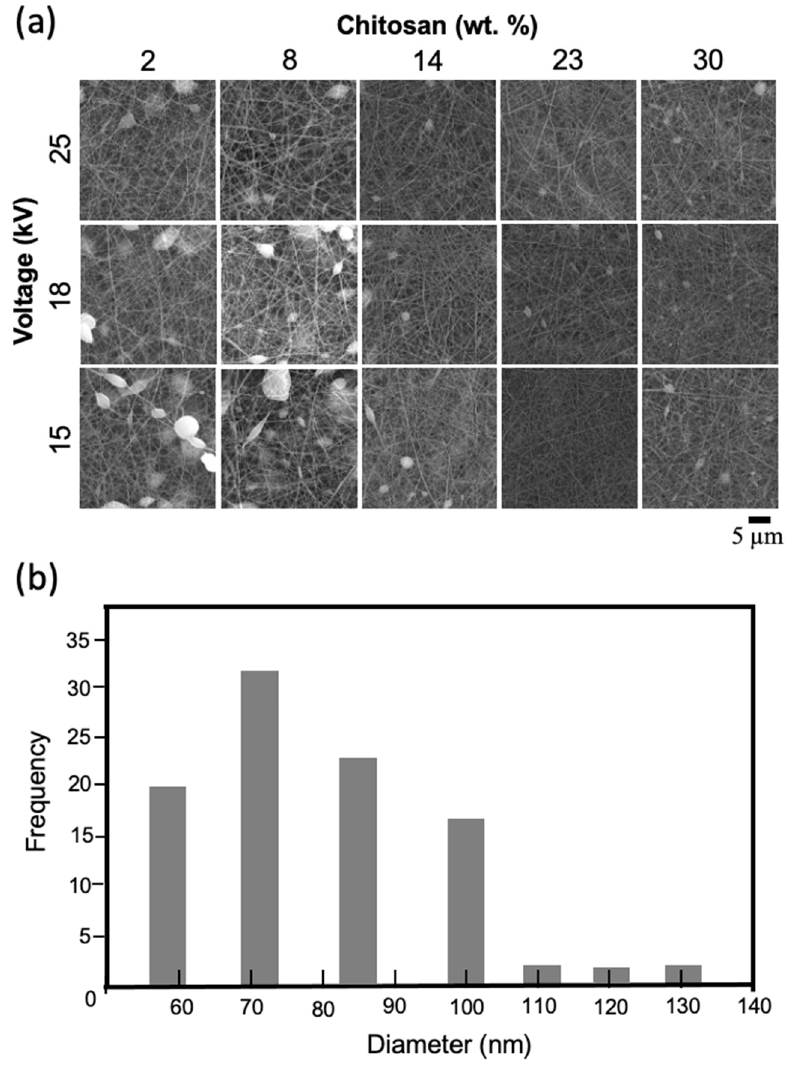
Figure 2. SEM images of ( a ) CS/PCL nanofibers with different chitosan concentration (wt.%) and applied voltage; and ( b ) fiber diameter distribution of CS/PCL produced at applied voltage of 15 kV with 23 wt.% CS.